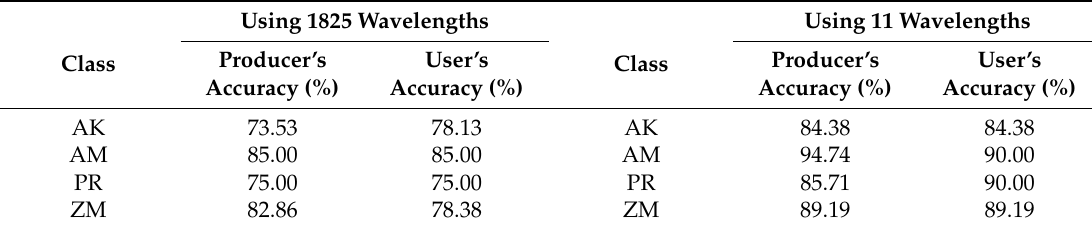
Table 3. Producer’s accuracy (%) and user’s accuracy (%) of the four classes (AK, AM, PR and ZM) using all of the variables (1825 wavelengths) and the most important variables (11